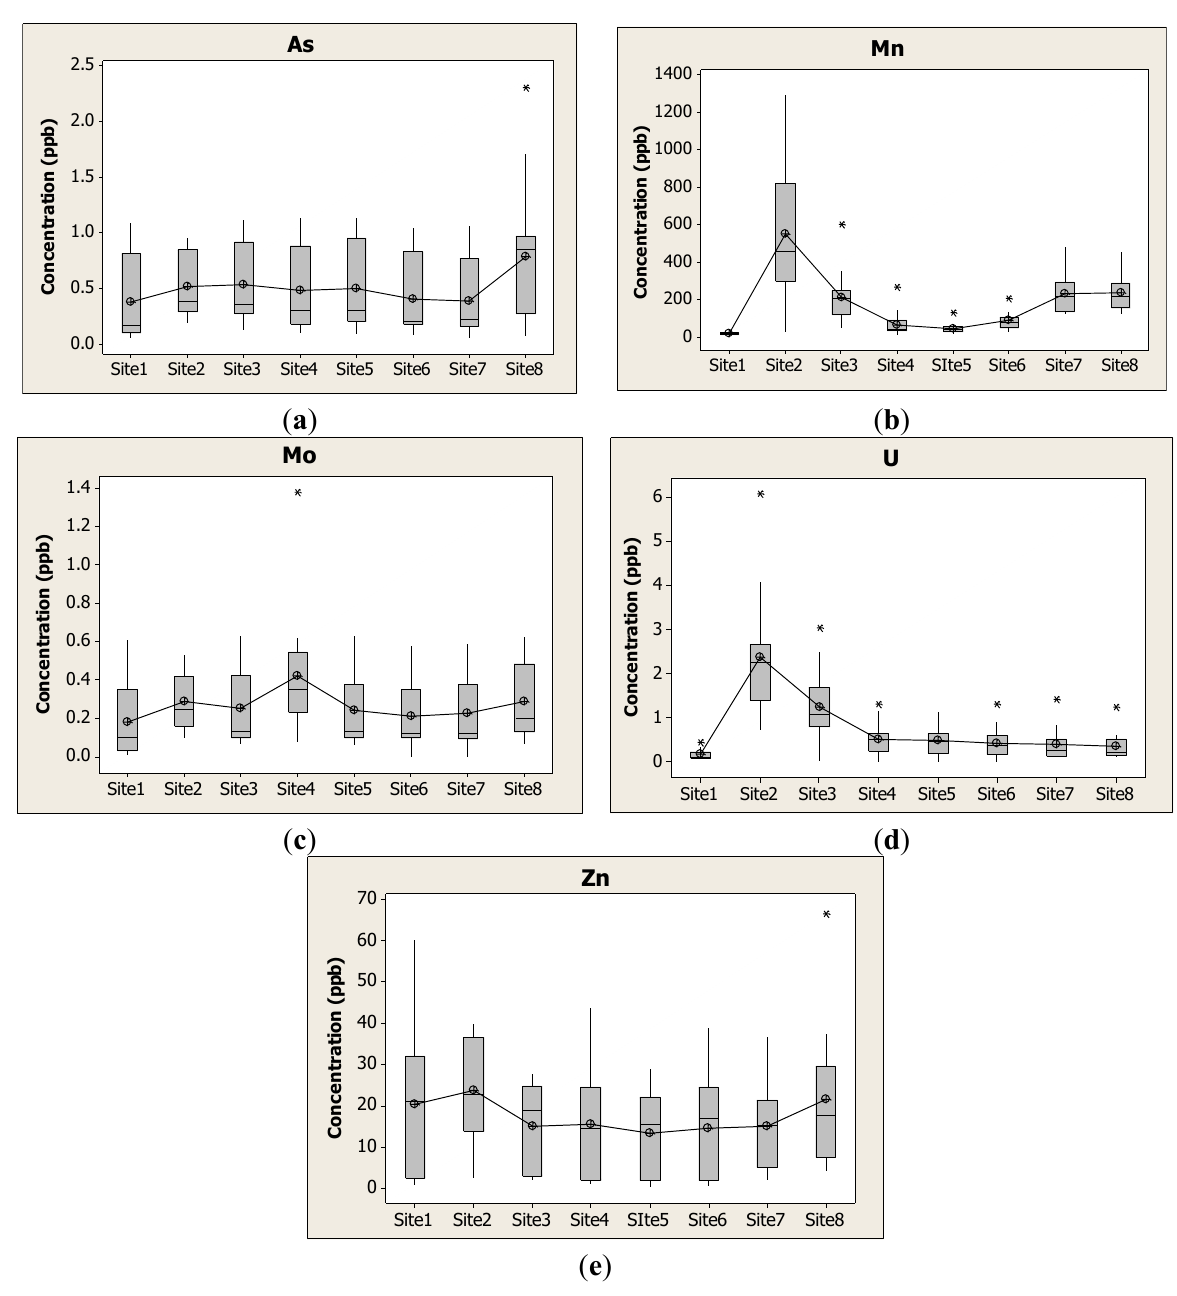
Figure 2. Boxplots of concentration data in 8 sites of: ( a ) As; ( b ) Mn; ( c ) Mo; ( d ) U; and ( e )